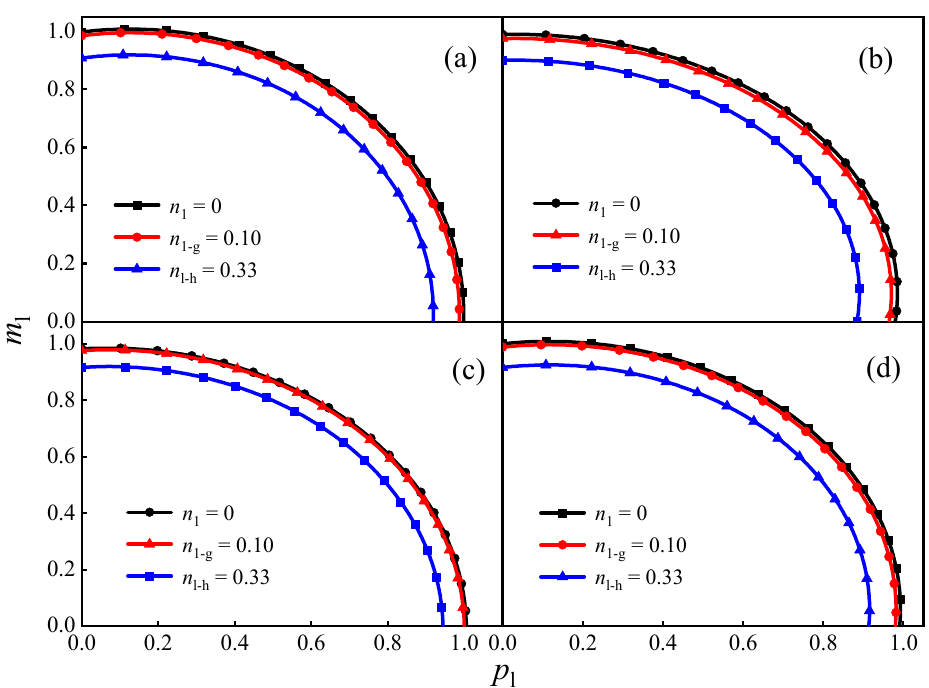
Figure 10. The effect of torque on the limit load curves of straight pipes with local wall-thinning defects under the combination of internal pressure and bending moment: ( a ) axial defect; ( b ) circumferential defect; ( c ) large-area defect; ( d ) small-area defect. Table 10. The relative reduction in the average radius of the limit load curves of straight pipes with local wall-thinning defects under the influence of torque.